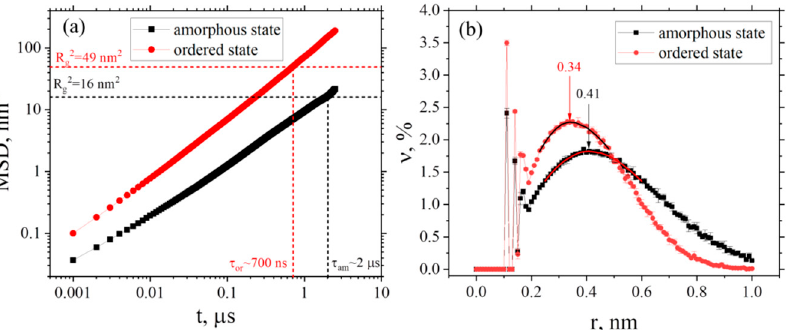
Figure 3. ( a ) Time dependence of the MSD of BPDA-P3 polymer chains’ centers of mass in amorphous (black line and filled squares) and ordered (red line and filled circles) states. The dotted line indicates the radius of gyration for the polymer chains in amorphous (black) and ordered (red) states, and the times at which the polymer chains shift to their own dimensions. ( b ) Free volume distribution (% of the total fraction of free volume) in amorphous (black line and filled squares) and ordered (red line and filled circles) states.